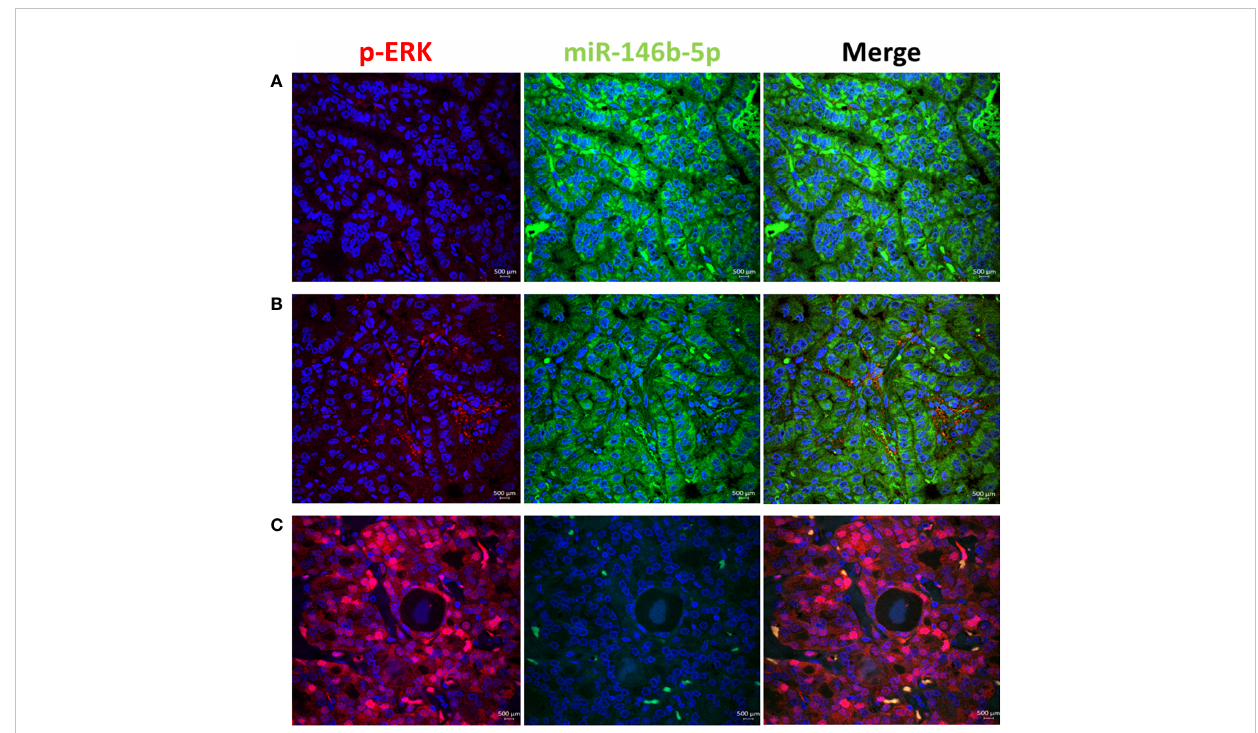
FIGURE 4 ERK pathway activity in relation to miR-146b-5p expression in representative thyroid tissues. (A) In PTC no phospho-ERK (red) is detected in the nuclei of tumor cells with high level of miR-146 (green). (B) p-ERK in negative along with low level of miR146b-5p. (C) In NIFTP strong nuclear expression of p-ERK is detected in tumor cells with no expression of